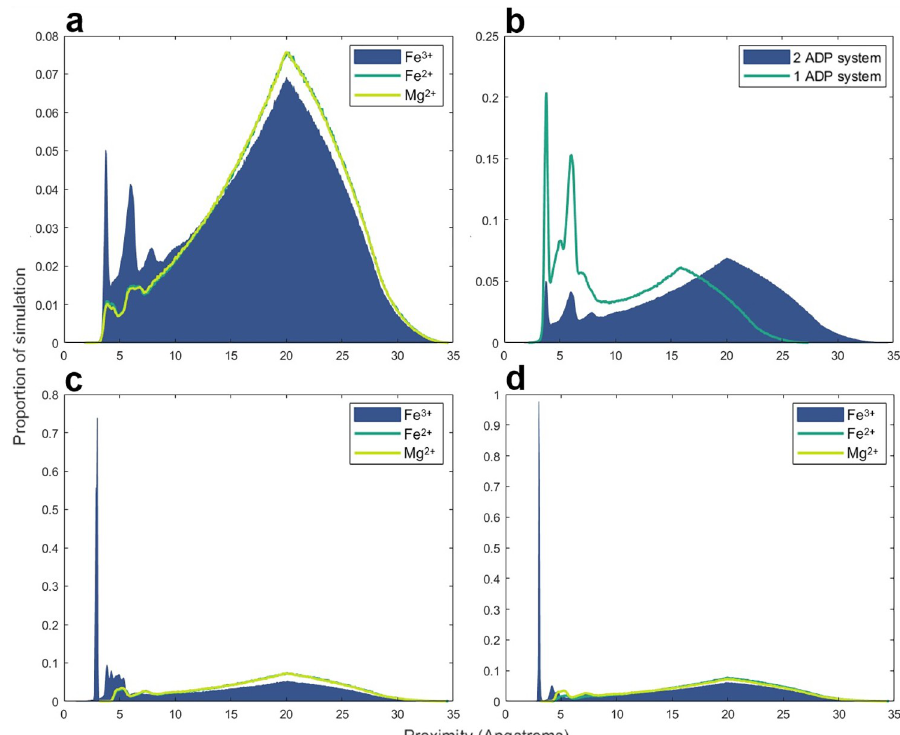
Fig 6. MD simulations. (a) . Proximity of AcP phosphate to ADP beta phosphate oxygens in the presence of either Fe 3 + , Fe 2+ , or Mg 2+ . System components: 2 ADP, 8 AcP, 8 Li + , 4 Na + , 12 K + , 18 Cl − , and either 2 Fe 3+ , 2 Fe 2+ , or 2 Mg 2+ . ADP and AcP both have charges of 2 − . ( b). Proximity of AcP phosphate to ADP beta phosphate oxygens with either 1 or 2 ADPs with constant molecular and ionic ratios. The 2-ADP system is the same experiment as the ferric iron simulation from panel (a). The 1-ADP system uses the same molecule and ion ratios but with the total quantities halved. To maintain comparable concentrations, the periodic box size was reduced to 31.75 Å in the 1-ADP system. (c). Proximity of ADP beta phosphate to either Fe 3+ , Fe 2+ , or Mg 2+ in the simulations from panel (a). ( d). Proximity of AcP phosphate to either Fe 3+ , Fe 2+ , or Mg 2+ in the simulations from panel (a). The data underlying this figure can be found in Table V–Y in S1 Data (sheet 6). AcP, acetyl phosphate; MD, molecular